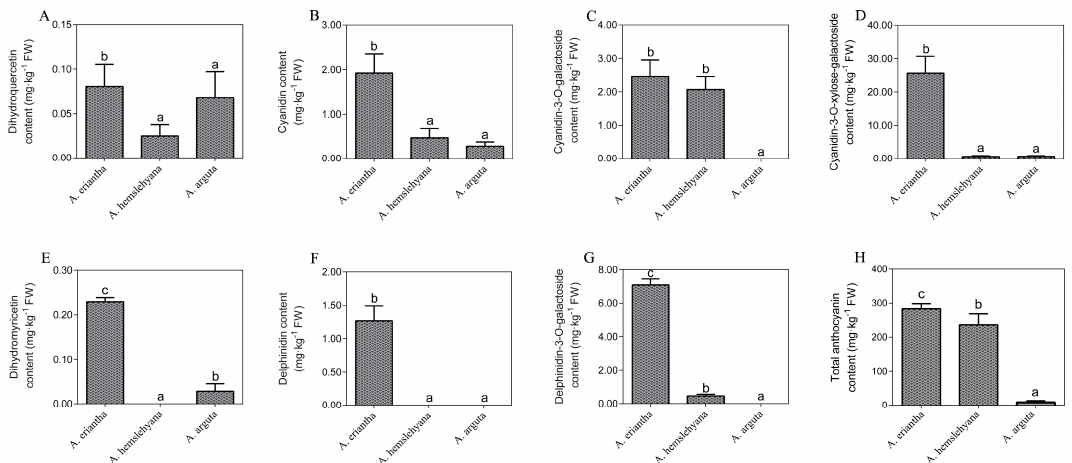
Figure 3. Anthocyanin components contents and their precursors including dihydroquercetin, dihydromyricetin, cyanidin, delphinidin, cyanidin-3-O-galactoside, delphinidin-3-O-galactoside and cyanidin-3-O-xylose-galactoside. ( A ) Dihydroquercetin content in three typed petals. ( B ) Cyanidin content in three typed petals. ( C ) Cyanidin-3-O-galactoside content in three typed petals. ( D ) Cyanidin-3-O-xylose-galactoside in three typed petals. ( E ) Dihydromyricetin content in three typed petals. ( F ) Delphinidin content in three typed petals. ( G ) Delphinidin-3-O-galactoside in three typed petals. ( H ) Total anthocyanin content in three typed petals. Data are means ± SE of three replicates. Error bars represent standard error of means. Columns with di ff erent lowercase letters are significantly di ff erent at P ≤ 0.05. Data were analyzed with Student’s t -test.